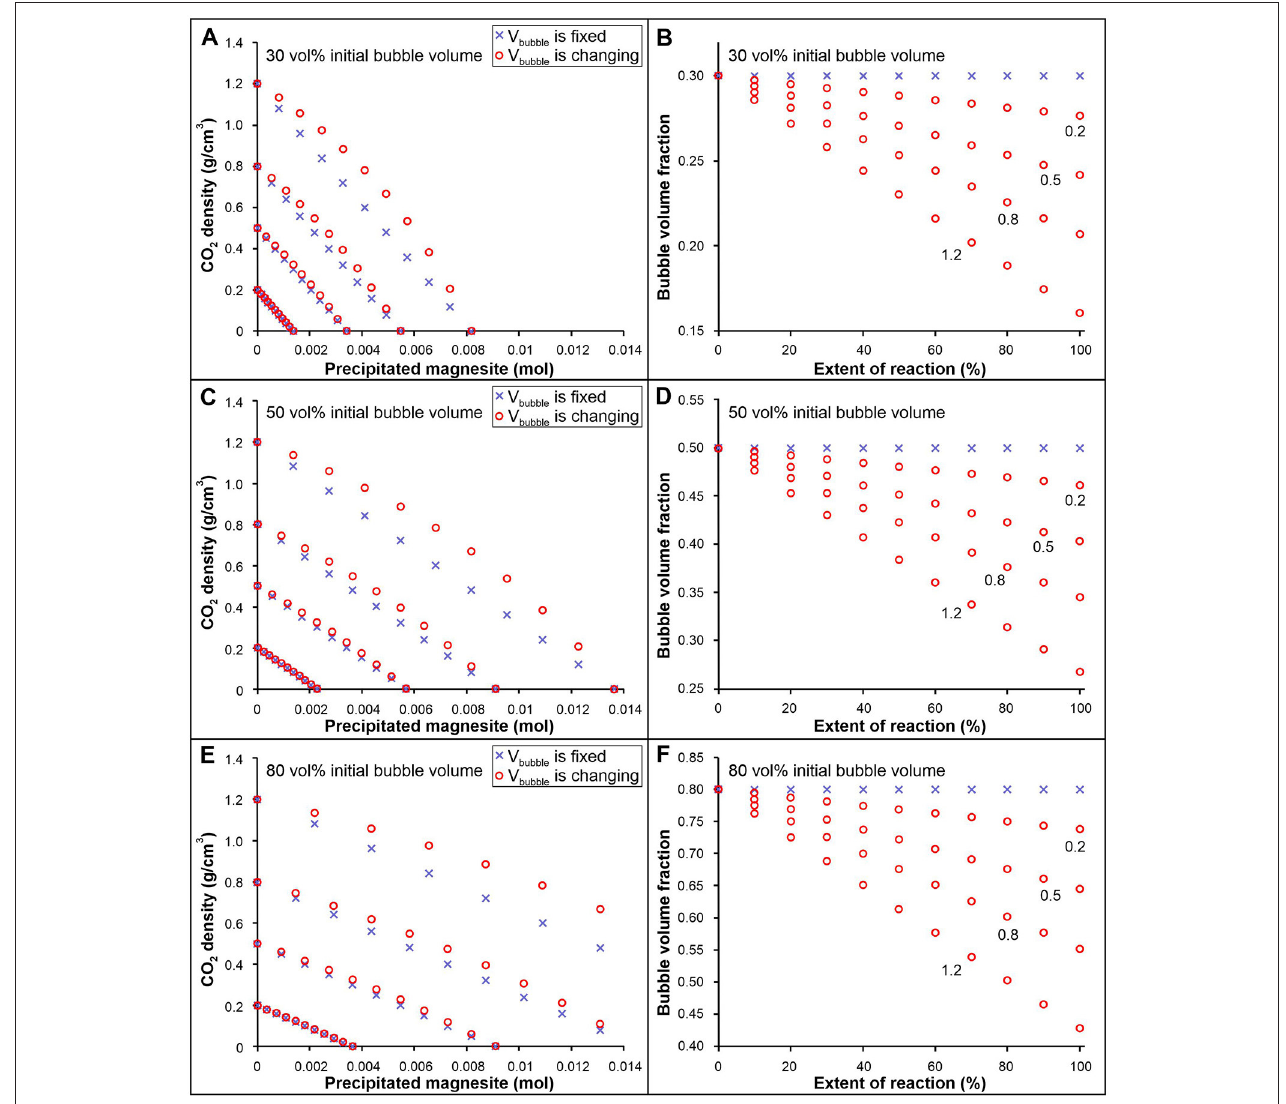
FIGURE 7 | Calculated variation in CO 2 density (A,C,E) and bubble volume (B,D,F) as the olivine carbonation reaction progresses assuming two scenarios: (1) the CO 2 -rich bubble volume remains constant (blue cross), and (2) the bubble volume changes as a result of the reaction according to equation (2) (red circle). The fluid inclusion is assumed to have a unit volume, and an initial volume fraction of the CO 2 -rich bubble of 0.3 (A,B) , 0.5 (C,D) , and 0.8 (E,F) . The initial CO 2 density ranges from 1.2 to 0.2 g/cm 3 . See text for more